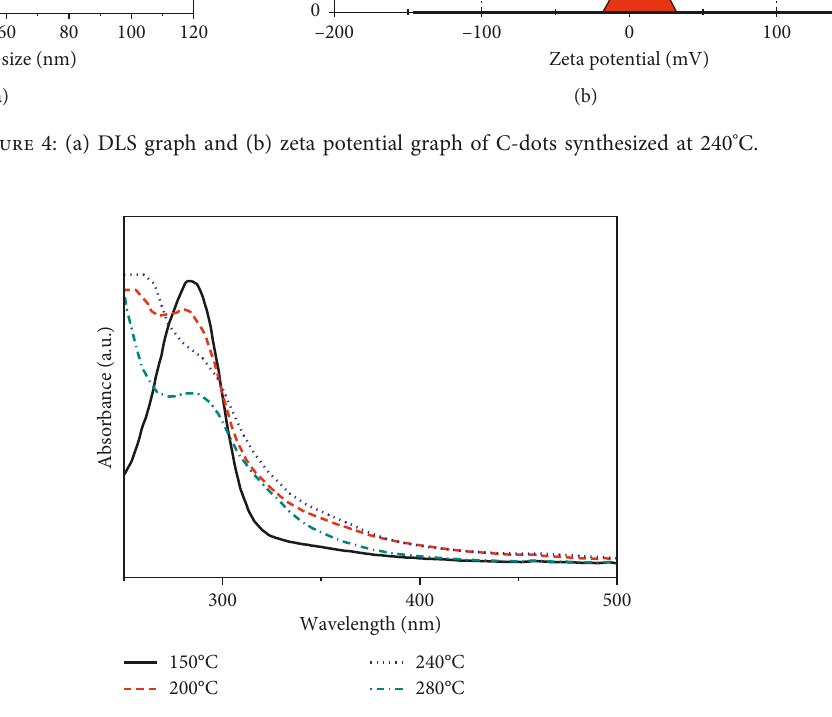
Figure 5: UV-Vis spectra of C-dots synthesized from lemon juice at 150, 200, 240, and 280 ° C.